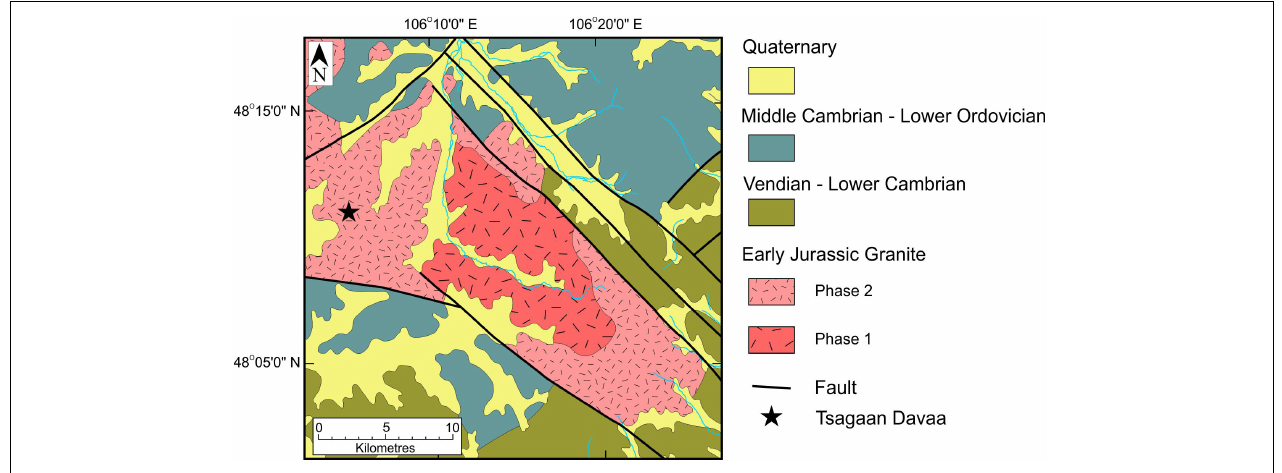
FIGURE 3 | Geological map of the southeastern part of the Tukhum pluton and surrounding units (modified after Dejidmaa, 2003; Dorjsuren and Bujinlkham, 2004) showing the location of the Tsagaan Davaa tungsten deposit.